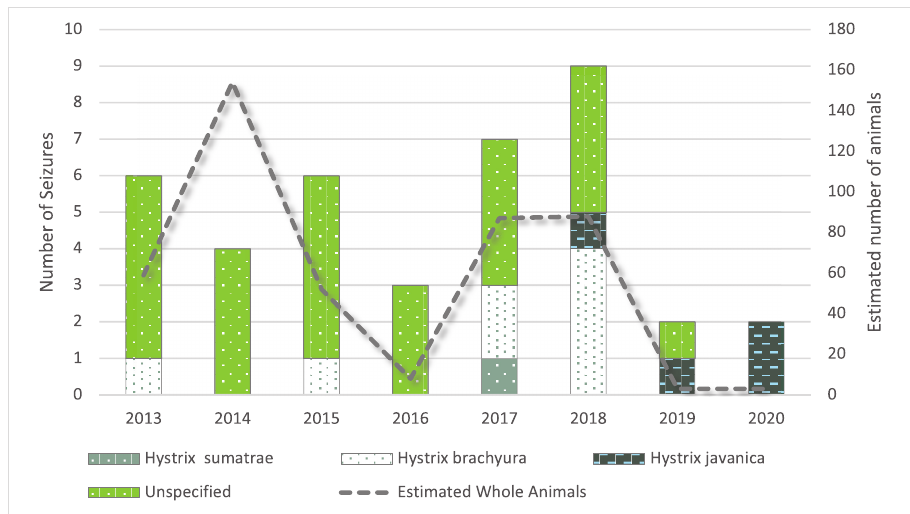
Figure 1. The number of seizure incidents involving porcupines in Indonesia from January 2013–June 2020, including species involved and estimated number of whole animals.